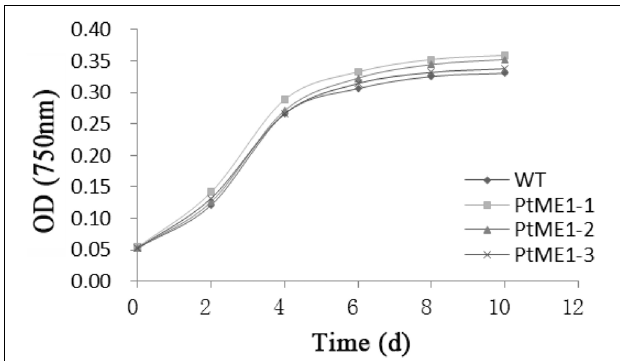
FIGURE 1 | Growth curves of transgenic clones and the WT strain. Values represent averages of three replicates ( n = 3).